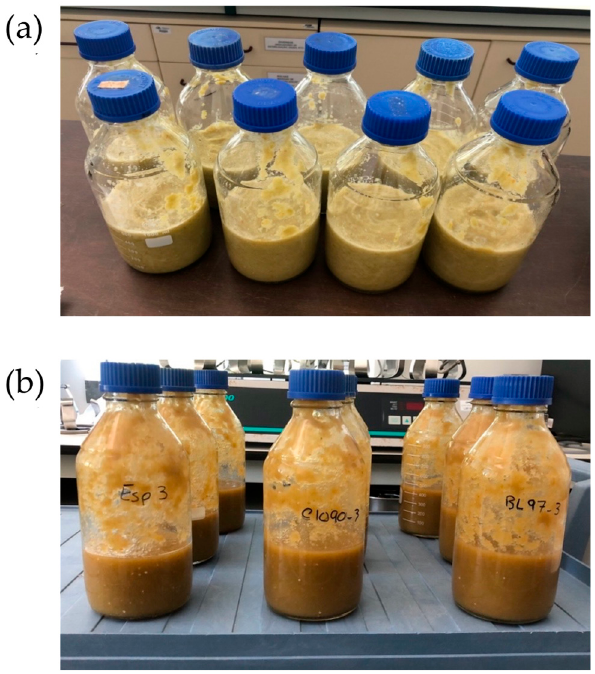
Figure 4. The appearance of unfermented ( a ) and fermented ( b ) immature tomato samples. The Δ E values express colour changes relative to the initial condition (unfermented